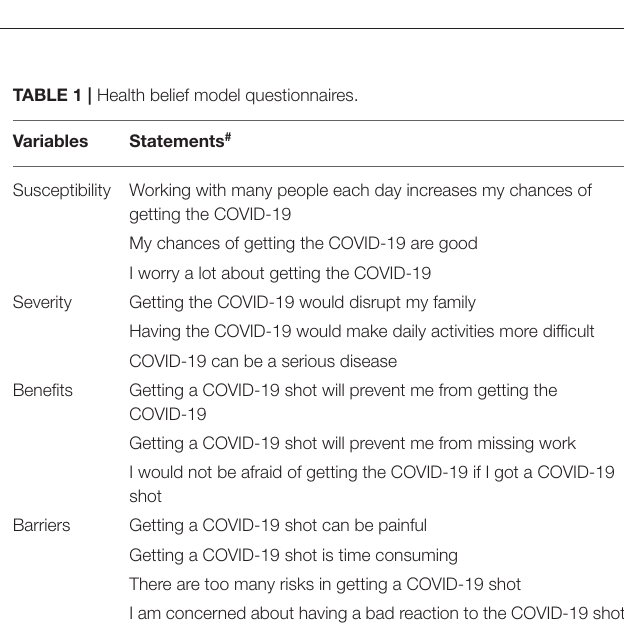
FIGURE 1 | Multi-mediation model.